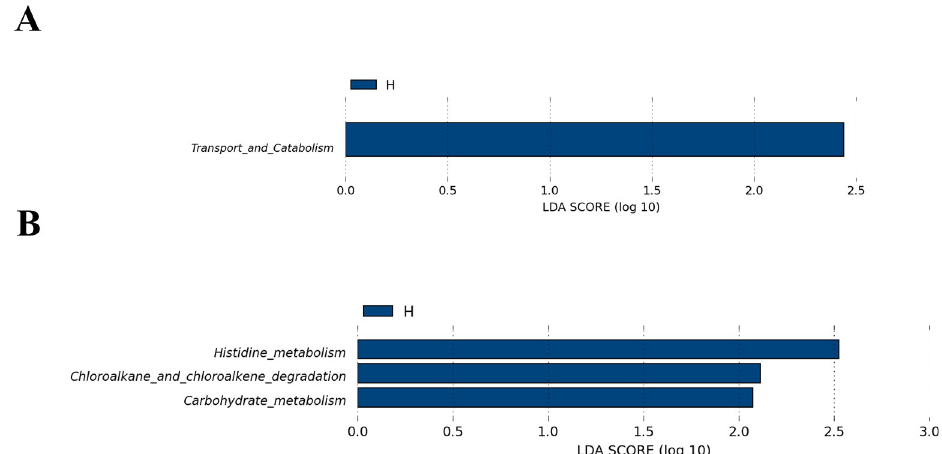
Fig 4. Functional predictions for the faecal microbiome of the higher-level (H) and the lower-level (L) groups. (A) A comparison of the enriched markers on level 2 of the KEGG functional category between the higher-level and lower- level athletes. (B) A comparison of the enriched markers on level 3 of the KEGG functional category between the higher-level and lower-level athletes. LDA, linear discriminant analysis.